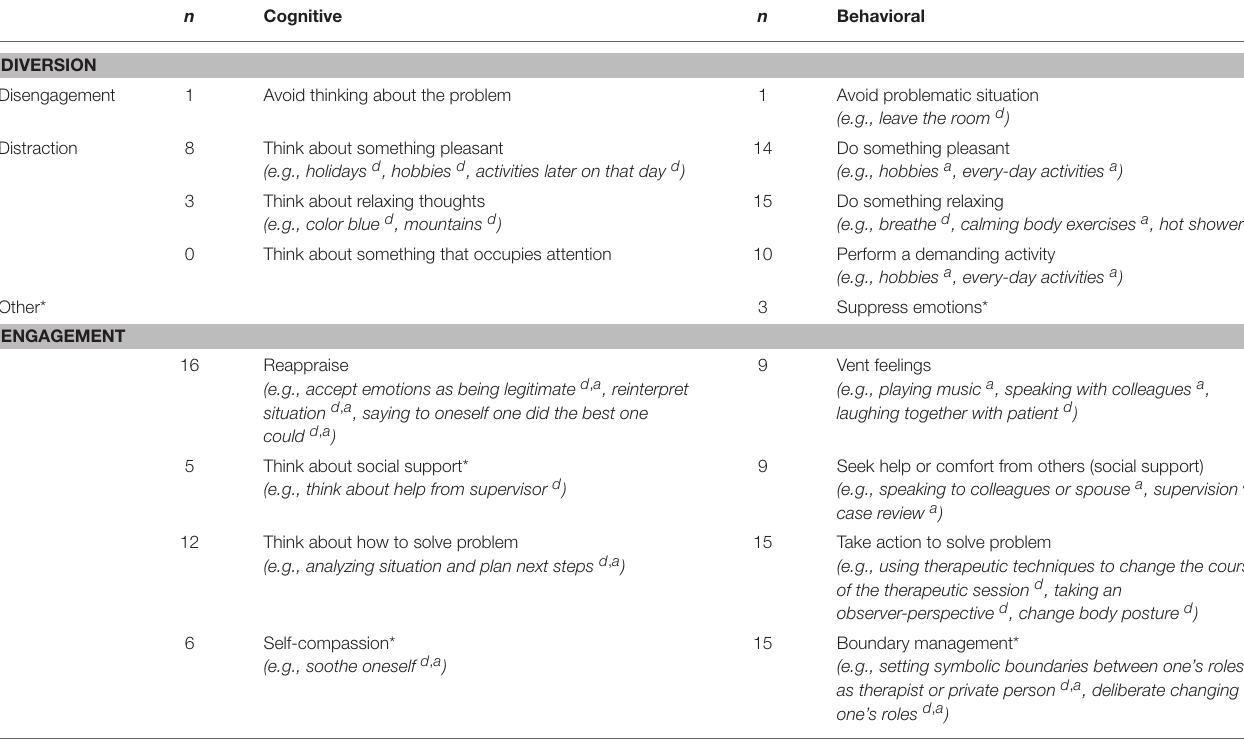
TABLE 4 | Emotion regulation strategies according to Parkinson and Totterdell (88) with examples of corresponding tactics used during ( d ) and after ( a ) therapy sessions from the present interviews (italics), and number of participants who reported having deployed the respective strategy. n Cognitive n